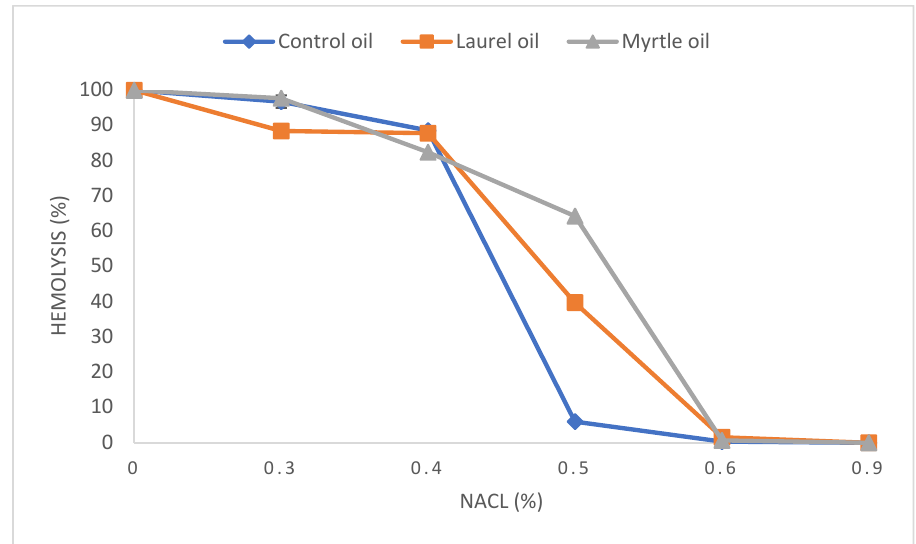
Figure 9. The effect of laurel and myrtle EO application on the osmotic fragility of blood samples at different concentrations of a sodium chloride solution. Female rats ( n = 5) were administered ig with laurel and myrtle EOs at a dose of 1 μ L per 1 g of rats once daily for 14 days. Laurel and myrtle EOs were mixed with sunflower oil (1:1) and the total daily volume per rat was 0.5 mL. The control group was treated ig with 0.5 mL of sunflower oil. The results are expressed as the mean value of each experimental group ± SEM.